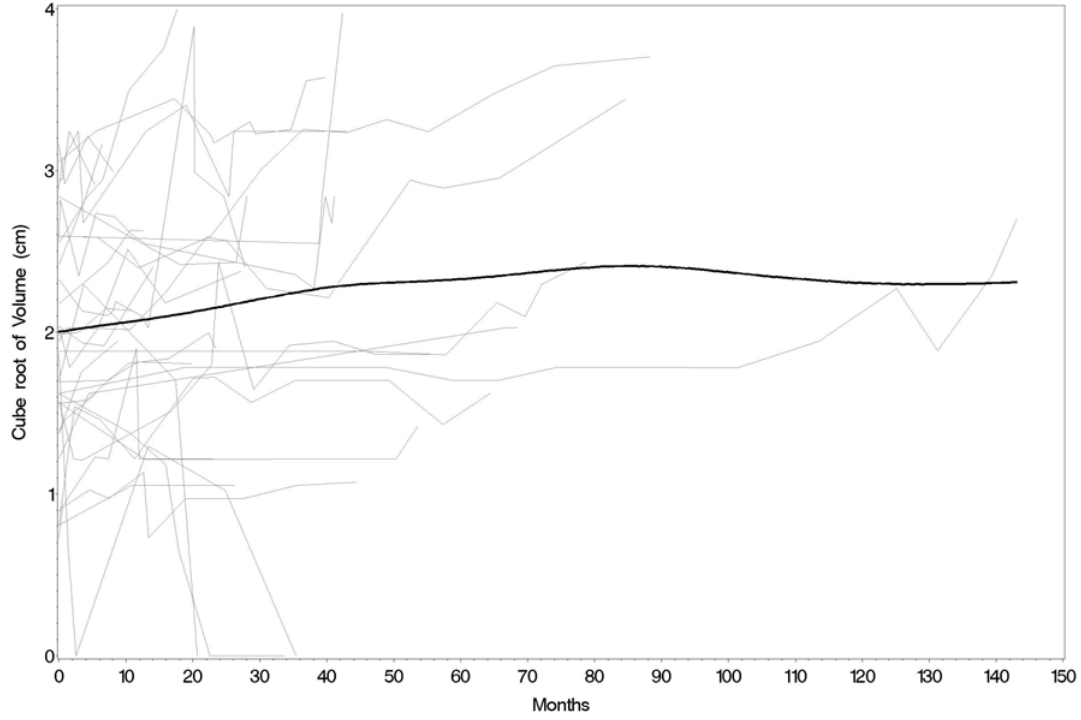
FIGURE 1. Individual observed patterns of tumor growth rate over time of 32 SRMs managed by active surveillance. A summary curve indicating the average growth rate is superimposed. (From Volpe et al.[42], with